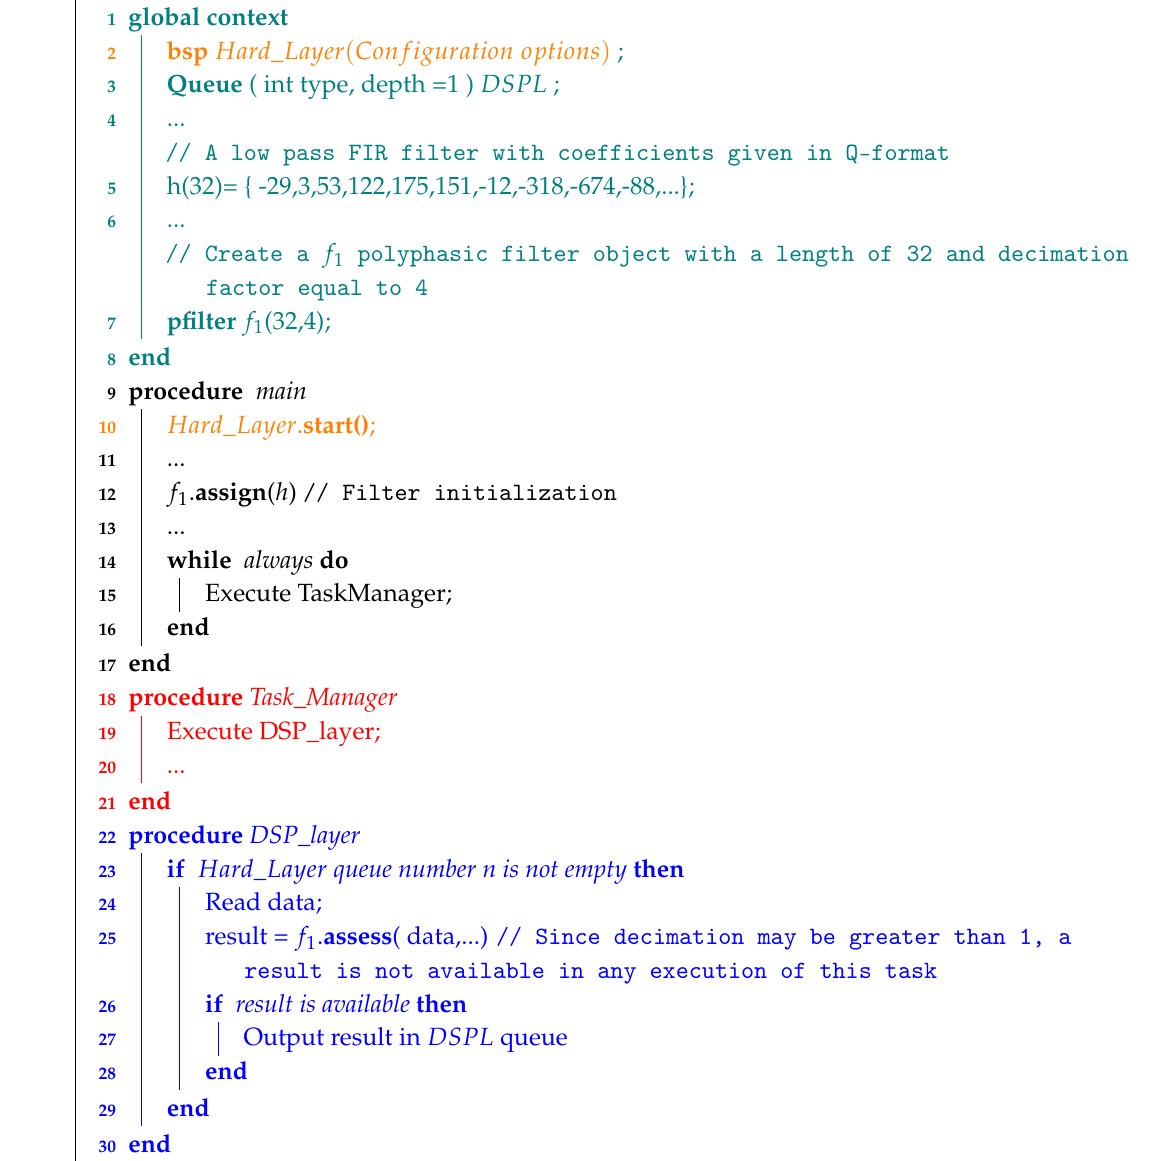
Algorithm 4: Programming example illustrating the usage of pfilter